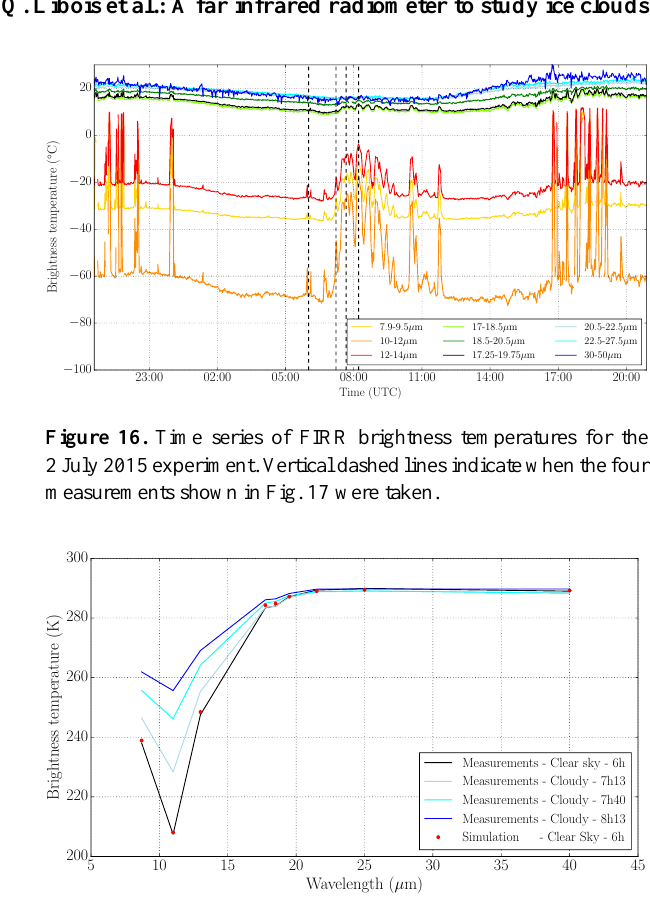
Figure 17. Brightness temperatures measured with the FIRR during the 2 July 2015 experiment. Four cases are shown with different cloud covers. They are also reported in Fig. 16. The MODTRAN simulation corresponding to the clear-sky conditions is indicated by red